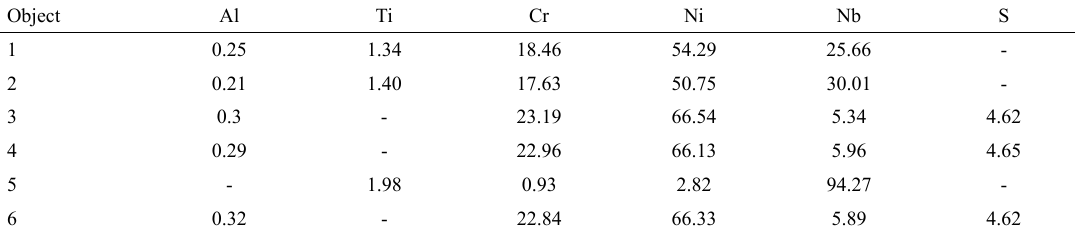
Table 4. Chemical composition (% by weight) of the analysed regions and precipitates